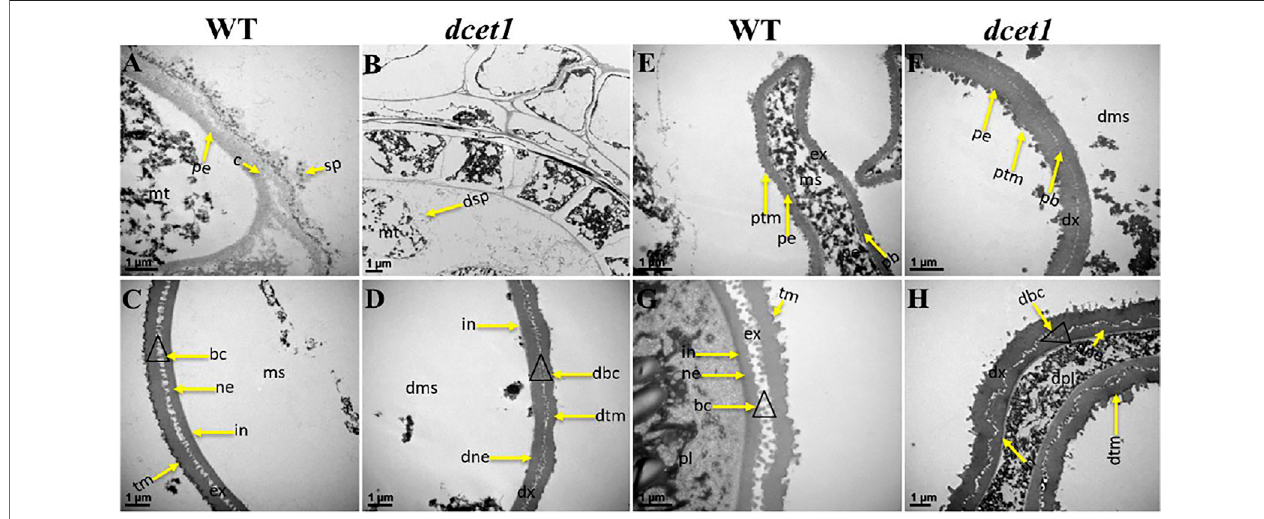
FIGURE 5 | TEM analysis of pollen wall development in the wild-type (WT) and mutant ( dcet1 ). Comparison of WT (A,C,E,G) and dcet1 (B,D,F,H) . mt, tetrad; ms, microspore,dms,defectivemicrospore;pl,pollen;dpl,defectivepollen;pe,primexine;sp,sporopollenin;dsp,defectivesporopollenin;ex,exine;dx, defectiveexine;ne, nexine; dne, defective nexine; pb, probocula; bc, bacula; dbc, defective bacula; tm, tectum; ptm, protectum; dtm, defective tectum; tr, tryphine; dtr, defective tryphine; in, intine. Scale bars (cid:1) 1